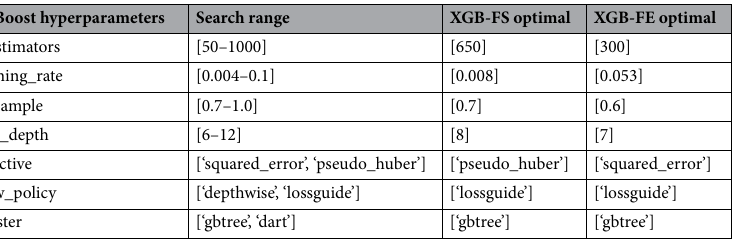
Table 3. Results of Bayesian Optimization with fivefold cross-validation, for XGB-FS and XGB-FE